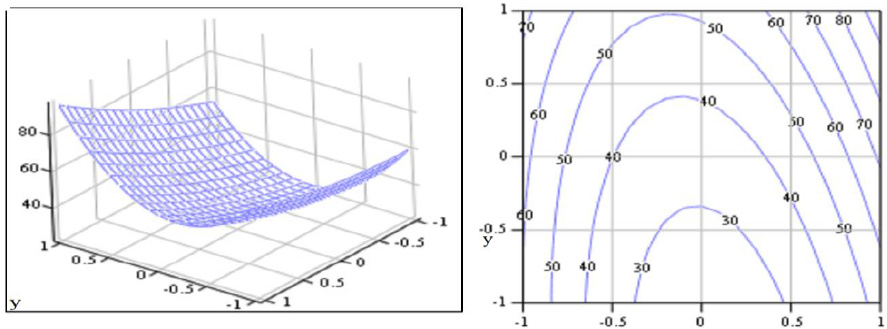
Figure 5. Graph and contour curves of the dependence of criteria Y on the factors х 1 , х 3 for cherries, when х 2 = 0.